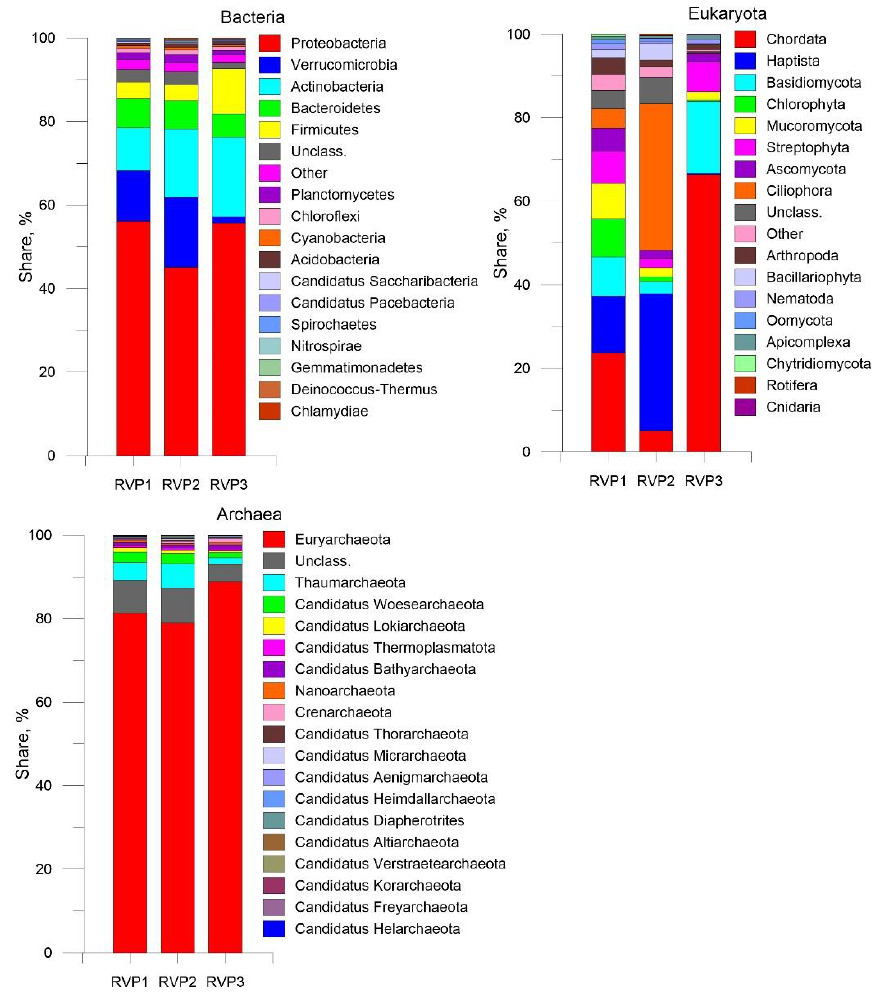
Figure 7. Abundance of taxa from three domains at the phylum level in the three metatranscrip-